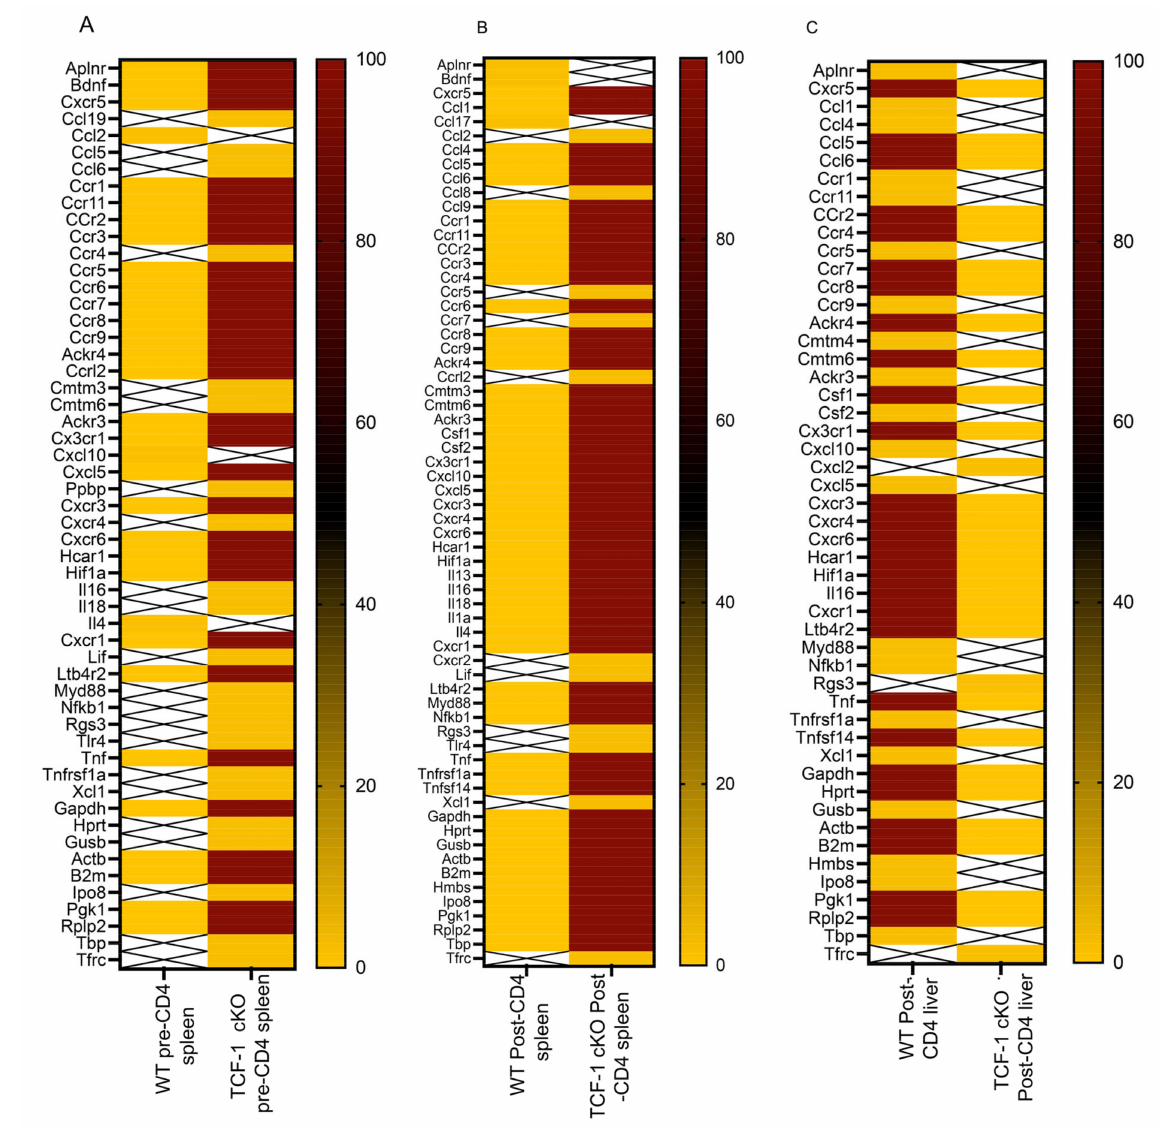
Figure 3. TCF-1 regulates chemokine/chemokine receptor expression in mature CD4 T cells during alloactivation. To perform the qPCR, BALB/c mice were lethally irradiated and allotransplanted, as described above. Donor CD4 T cells from WT and TCF-1 cKO mice were FACS sorted both pre- and post-transplant (7 days after transplant), from the spleen (both pre and day 7) and liver (day 7 only). The cells were sorted in TRizol, and RNA was extracted using chloroform and converted into cDNA using a synthesis kit (more details in Methods). cDNA was added to premade mouse chemokine/chemokine receptor primer plates (Invitrogen Carlsbad CA USA) and run on a